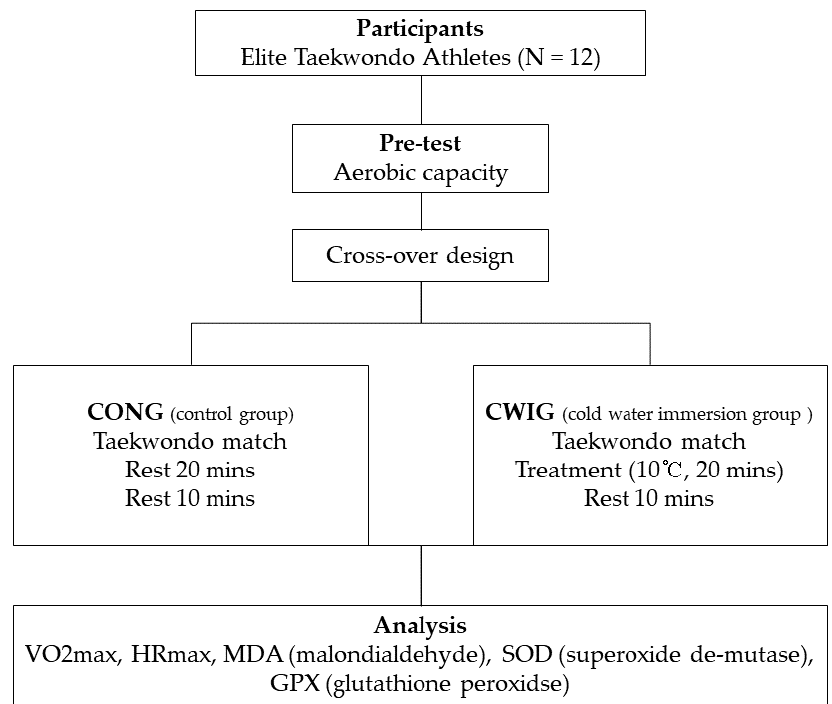
Figure 1. Study progression.